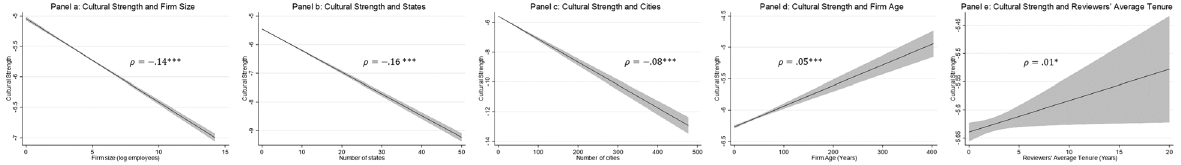
Fig. 3 Theory-driven covariates of cultural strength (computed on “ pros ” ). In Fig. 3, we report results from bivariate analysis showing the correlation of cultural strength with theoretically relevant variables of interest. + p < 0.1; * p < 0.05; ** p < 0.01; *** p <